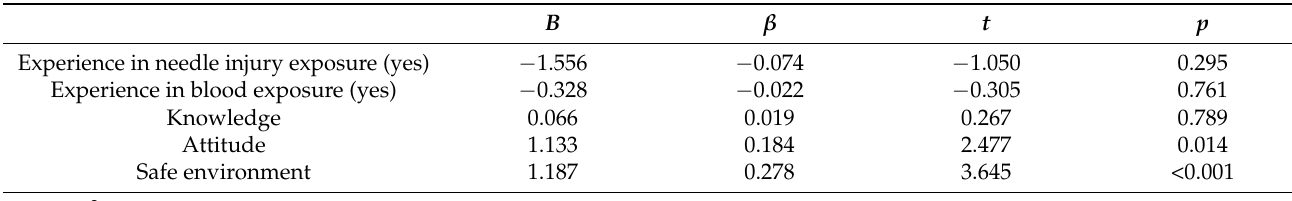
Table 6. Factors that impact on compliance with infection control practice ( n = 178).